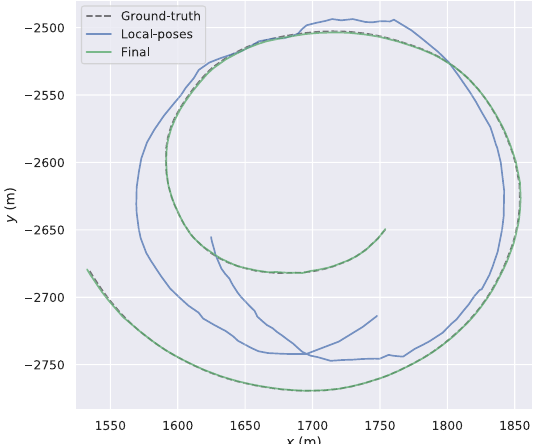
Figure 4. Example for the drift of ORB-SLAM2 if the local poses are only aggregated. The plot shows the ground truth as dashed line, the aggregated poses of ORB-SLAM2 in blue, and the final trajectory in green, each as a projection onto the XY plane.